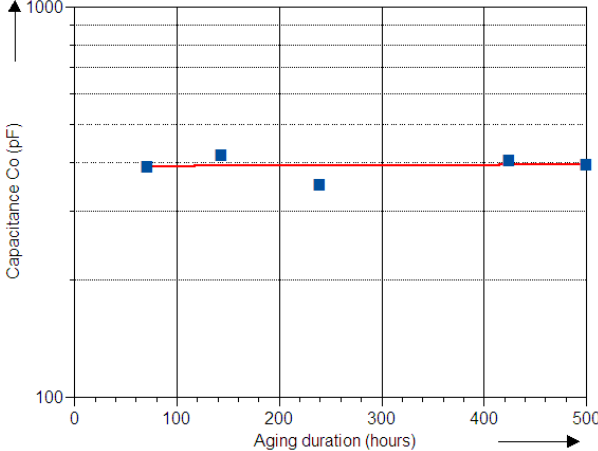
(at 115 °C) as a function of thermal 0